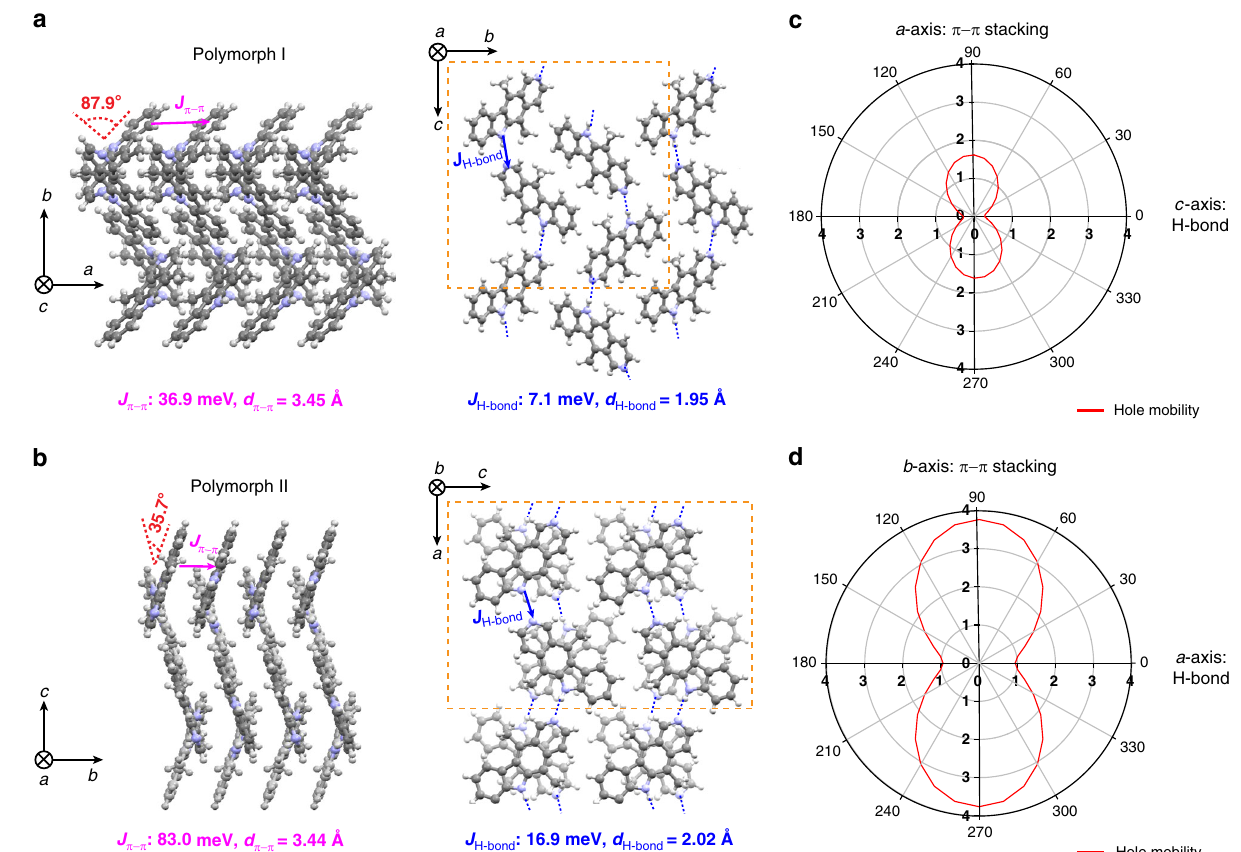
Fig. 2 Crystal structures and calculated hole mobilities for ellipticine. a , b Crystal structures of a polymorph I and b polymorph II viewed from the π − π stacking and the H-bonding directions. The corresponding calculated charge transfer integrals and the measured stacking distances were labeled. The blue dash lines denote H-bonds (NH to N). The yellow dash lines enclose one unit cell of the crystal lattice. c , d Calculated hole mobilities (in cm 2 V − 1 s − 1 ) of ellipticine c polymorph I and d polymorph II. In both cases, 0° corresponds the H-bonding direction, and 90° the π − π stacking